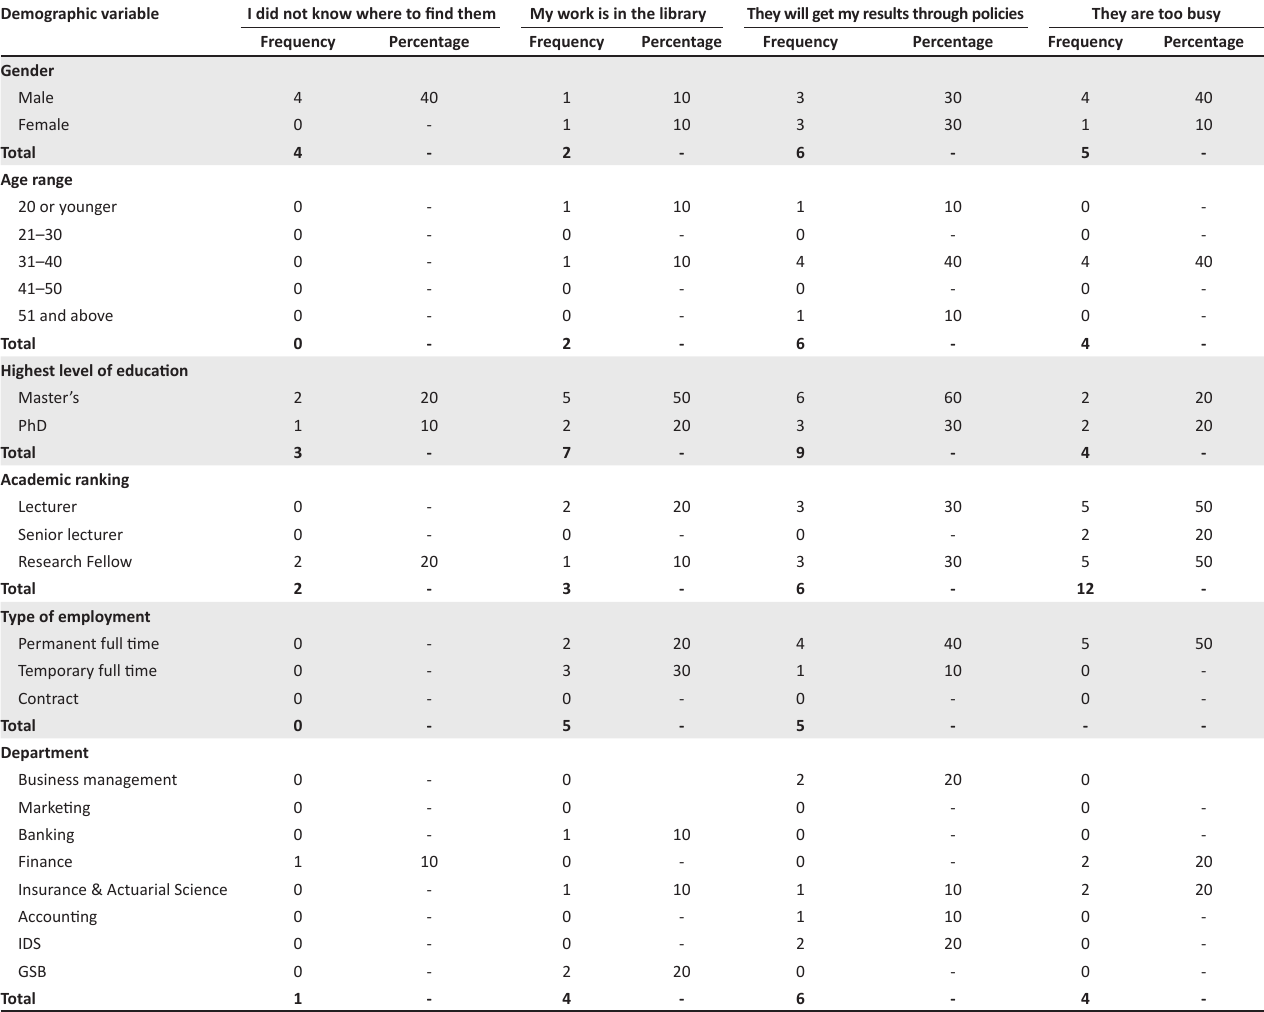
TABLE 4: Reasons for non-communication of results ( N = 10). Demographic